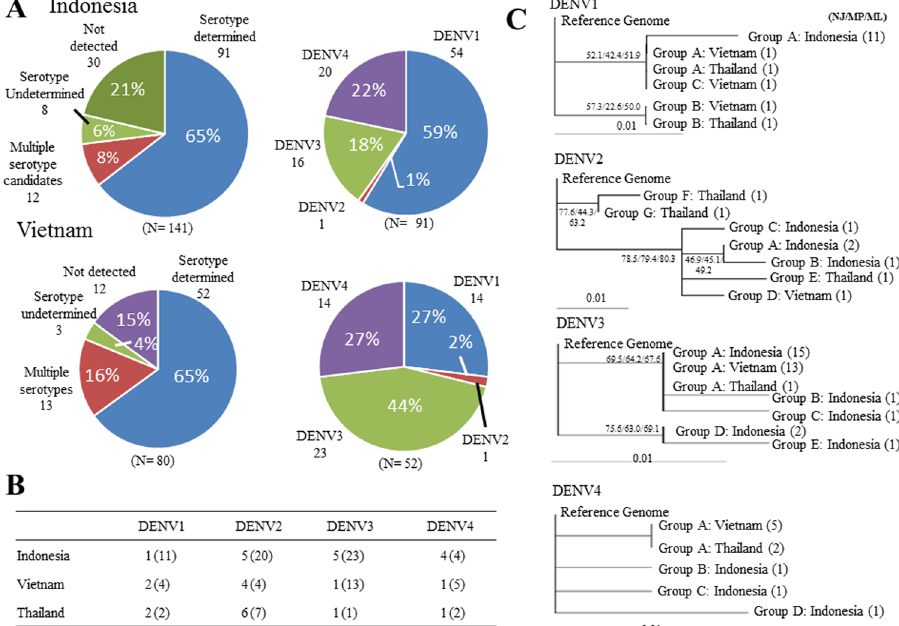
Figure 3. Serotyping of samples from Indonesia, Vietnam and Thailand. ( A ) Field application results from the serotyping analysis of 141 and 80 dengue patients from Indonesia and Vietnam, respectively. The left panels show the results of the viral identifications and their serotyping, and the right panels show the composition of the serotypes in this population. ( B ) SNVs found in each country for each serotype. The numbers in parentheses show the numbers of all samples that have SNVs, while the numbers outside the parentheses show the unique SNVs among those samples. ( C ) Phylogenetic tree showing the relationship of the DENVs from Indonesia, Vietnam and Thailand to the reference DENV for each serotype. A genetic distance of 0.01 is represented by the horizontal bar. Cross-validations by NJ (neighbor-joining)/MP (maximum parsimony)/ML (maximum likelihood) methods are shown in the margin. See the Materials and Methods section for further details. Note that for ( B and C ), the SNVs detected from the “serotype determined” and “multiple serotype candidates” groups were